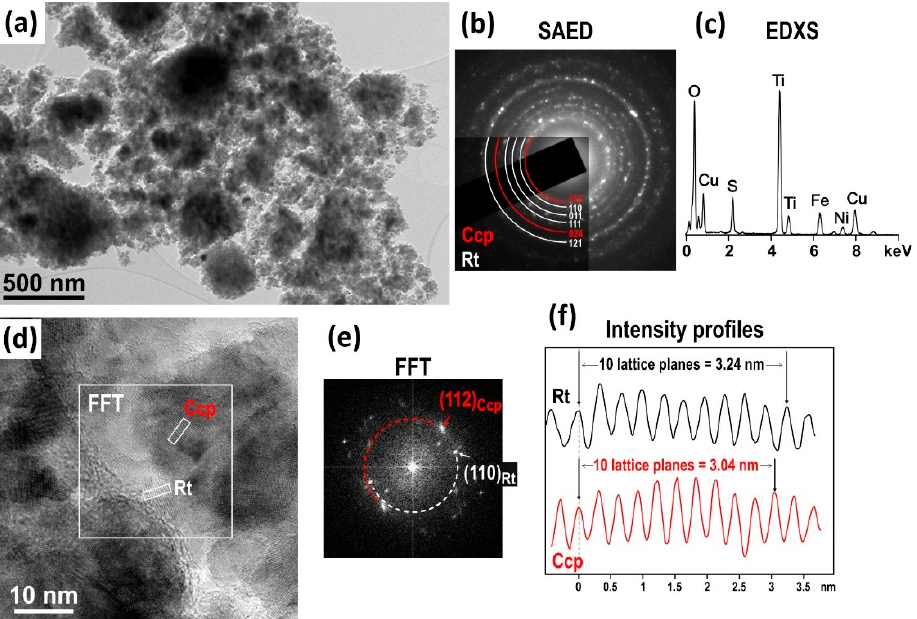
Figure 3. TEM analysis of CuFeS 2 /TiO 2 nanocomposite: ( a ) TEM image at low magnification with indexed SAED pattern that contains diffraction rings of rutile (Rt) and chalcopyrite (Ccp); and EDXS spectrum shows the presence of Cu, Fe, S, Ti and O in the sample. The SAED pattern ( b ) and EDXS analyses ( c ) included circular areas with approximately 500 nm diameter. ( d ) High-resolution TEM image of the sample. The presence of Rt and Ccp grains was confirmed by FFT analysis ( e ) and from intensity profiles ( f ) taken across the crystallites with visible lattice spacings. See text for more de- tailed description.